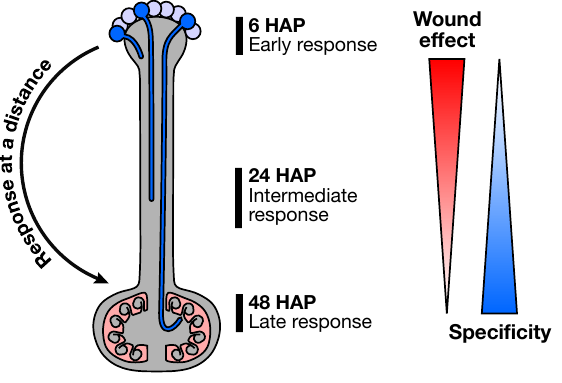
Figure 8. Outline of the at a distance ovary response following pollination. Early pollination response, irrespective of the pollination type, is akin to a wound response. As the PT grow, each pollination type is then recognized as distinct and produce a highly specific transcriptomic signature in the ovary, before PT